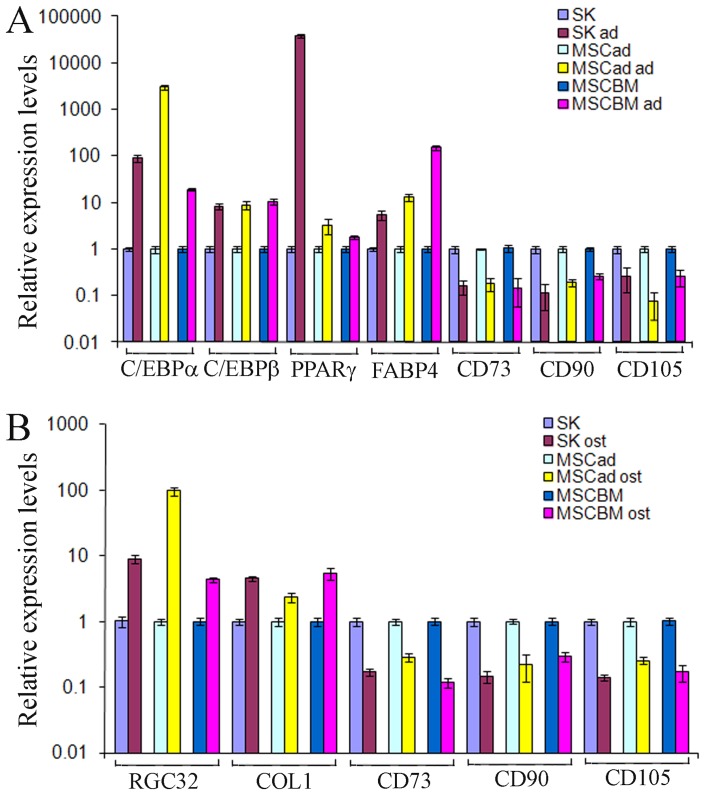
Gene expression patterns in differentiated SK cells, MSC-ad and MSC-BM.A and B, expression levels of adipocyte genes, C/EBPα, C/EBPβ, PPAR-γ, and FABP4 (A), osteoblast genes, RBC32 and COL1 (B), and MSC genes, CD73, CD90, and CD105 (A and B) were measured by quantitative PCR in differentiated SK cells, MSC-ad and MSC-BM at day 15 after differentiation. Abbreviations: SK, SK Hep-1 cells; MSC-ad, adipocyte-derived MSC; MSC-BM, bone marrow-derived MSC; FABP4, fatty acid binding protein 4; RBC32, response gene to complement 32; COL1, collage 1A1.